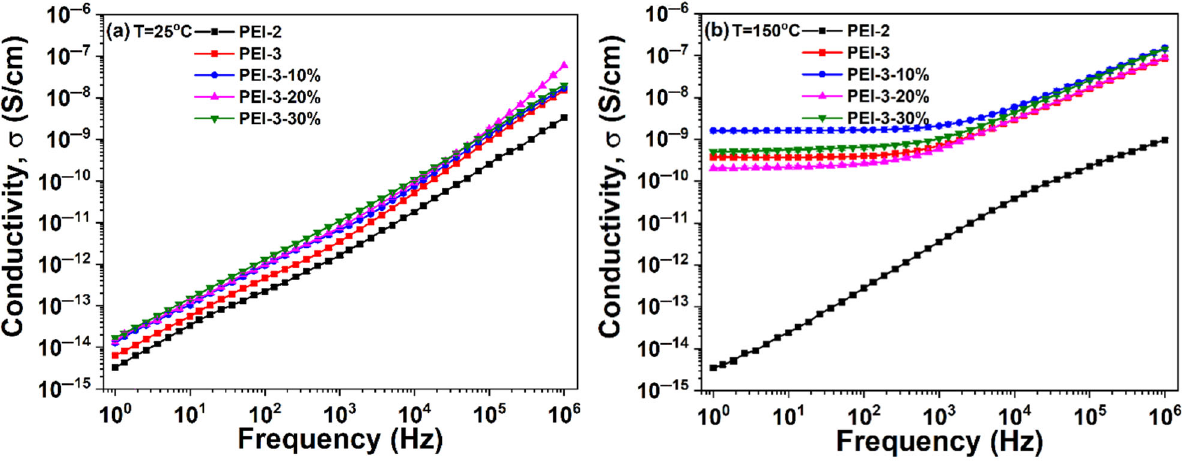
Figure 13. The evolution of measured conductivity with frequency at room temperature ( a ) and at 150 C ( b ) for the studied materials.